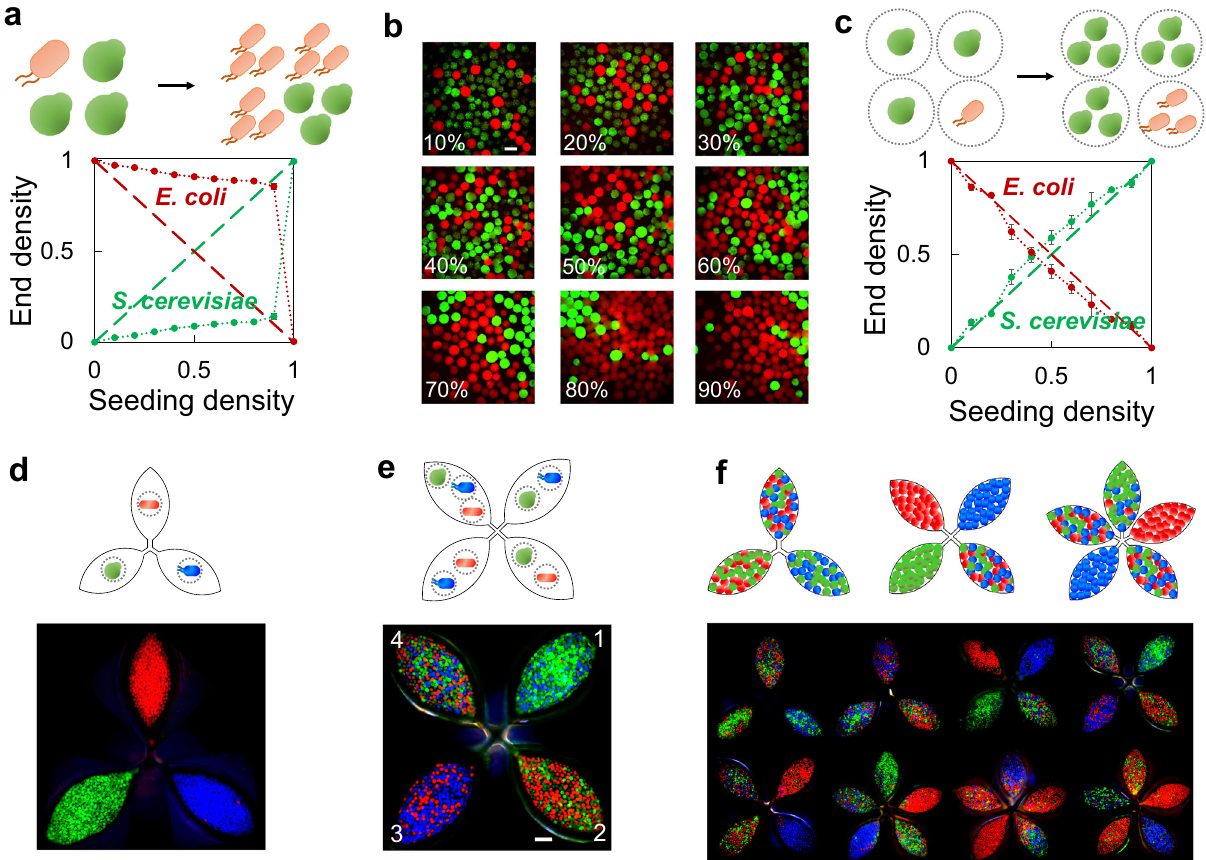
Fig. 4 MSBC platform built multispecies consortia with fl exibility and precision. a Faster-growing E. coli overtook the S. cerevisiae in a well-mixed consortium. Cell mixture ( S. cerevisiae (BY4742 expressing GFP) and E. coli (MG1655 expressing mCherry) at different seeding ratios) were inoculated into the medium, cultured at 30 °C for 24 h and quanti fi ed by fl ow cytometry. The dotted and dashed lines showed the actual and ideal composition, respectively. The x axis indicated the seeding density of S. cerevisiae ( N S : cerevisiae ). In all conditions, the faster-growing E. coli became dominant. b The N S : cerevisiae þ N E : coli growth of E. coli and S. cerevisiae in MSBC was constrained inside their own niche with a de fi ned boundary. We mixed the MSB( S. cerevisiae ) and MSB( E. coli ) at different seeding ratios (~2000 MSBs in total), and cultured the MSBC at 30 °C for 24 h. In all conditions, two species grew inside their own MSBs without interference and were able to maintain a desired population ratio consequently. Numbers indicated the seeding density of MSB( E. coli )